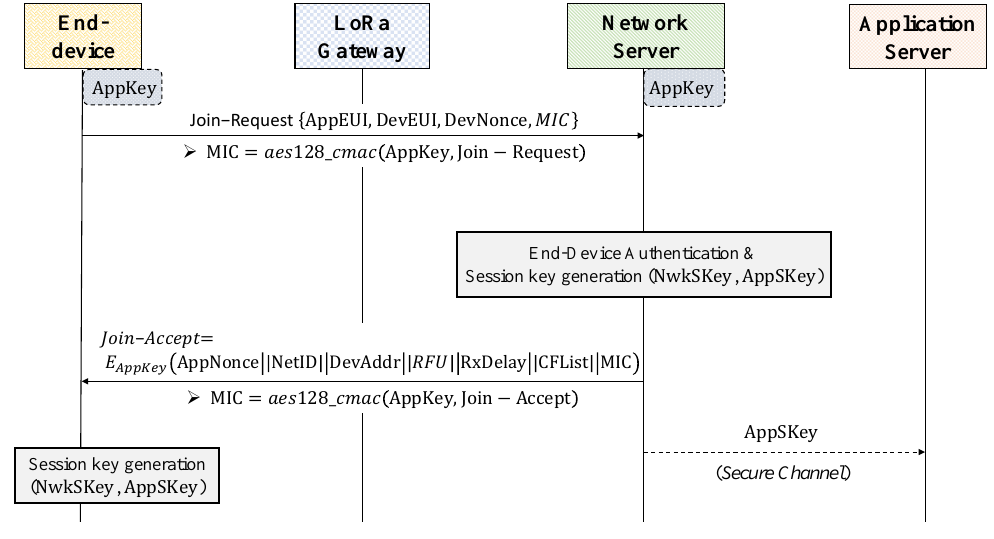
Figure 4. Join procedure in the LoRaWAN specification.